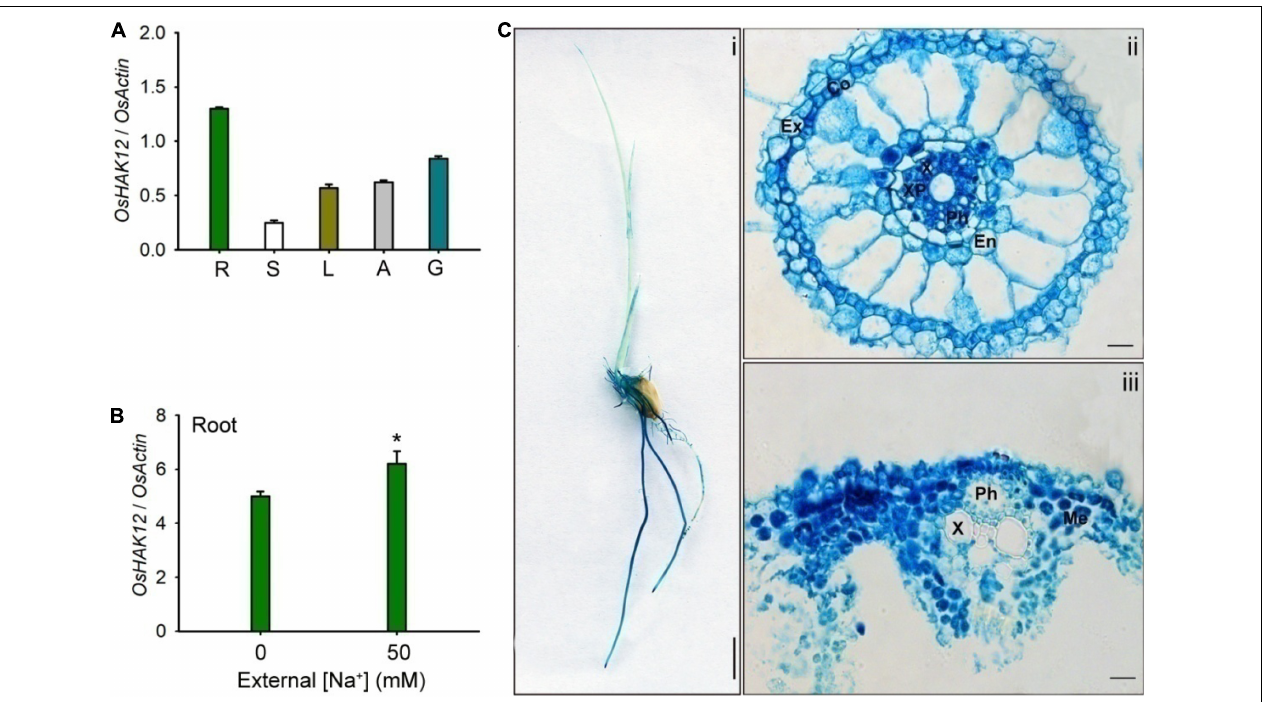
FIGURE 2 | Expression pattern of OsHAK12 . (A) OsHAK12 mRNA accumulation by real time qRT-PCR analyses in different rice tissues as indicated in this figure. Nipponbare rice seedlings were grown in soil for 12 weeks. R, root; S, shoot; L, leaf; A, anther; G, glume. (B) The transcriptional expression of OsHAK12 in rice under different salt concentrations treatment. 3-days-old Nipponbare rice seedlings were cultivated in hydroponic culture for 7 days, and then transferred to the culture containing 50 mM Na + for 12 h. Total RNAs were isolated from the rice seedlings, and the mRNA levels of OsHAK12 were examined by real time qRT-PCR. OsActin was used as an internal reference. Significant difference was found between 0 or 50 mM NaCl samples are indicated in rice seedlings (* P < 0.01 by Student’s t -test). (C) Histochemical analysis of GUS expression for OsHAK12 . 3-days-old Nipponbare rice seedlings were cultivated in hydroponic culture for 4 days, then GUS activities were determined after histochemical staining. Blue indicates GUS activity. (i) GUS staining of 7-days-old plants grown in hydroponic cultures with IRRI solution. (ii) Cross section images of the elongation zone in (i). (iii) Cross section images of the leaf vascular tissue in (i). Ex, exodermis; Co, Cortex; En, endodermis; Ph, phloem; X, xylem; XP, xylem parenchyma; Me, mesophyll cells. Bar in (i) = 1 cm and bars in (i) to (iii) = 100 µ m. The experiment was repeated five times with similar results. Data are means of five replicates of one experiment. Asterisks represent significant differences. Error bars represent ±